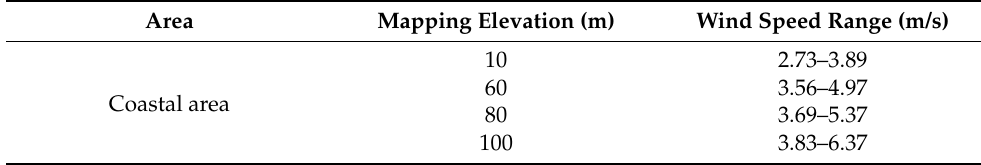
Table 8. The wind speed range for the microscale maps in the coastal area of Bangladesh. Area